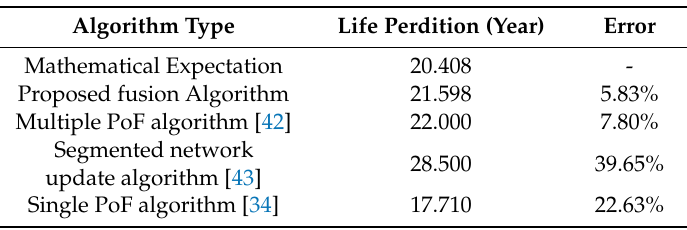
Table 8. Comparison of life